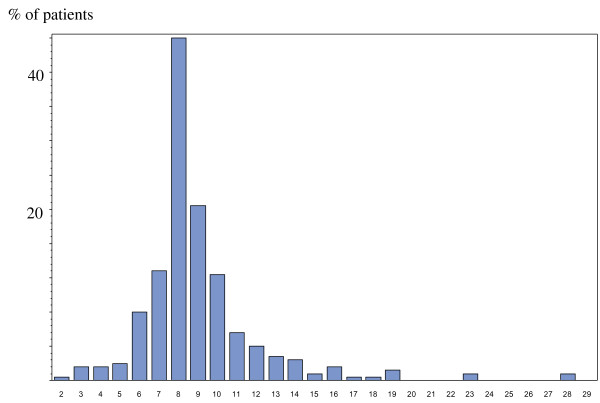
Distribution of parathyroid hormone (PTH) according to multiples of the upper normal limit for the assays in the EPHEYL study.